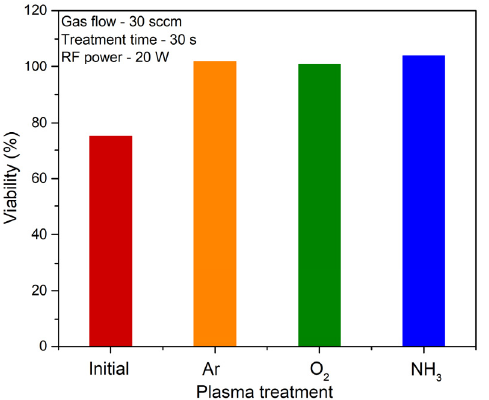
Figure 9. Cell viability for the L929 fibroblasts grown on the PNIPAAM initial surface as obtained by spin coating and respectively treated in argon, oxygen and ammonia plasma.